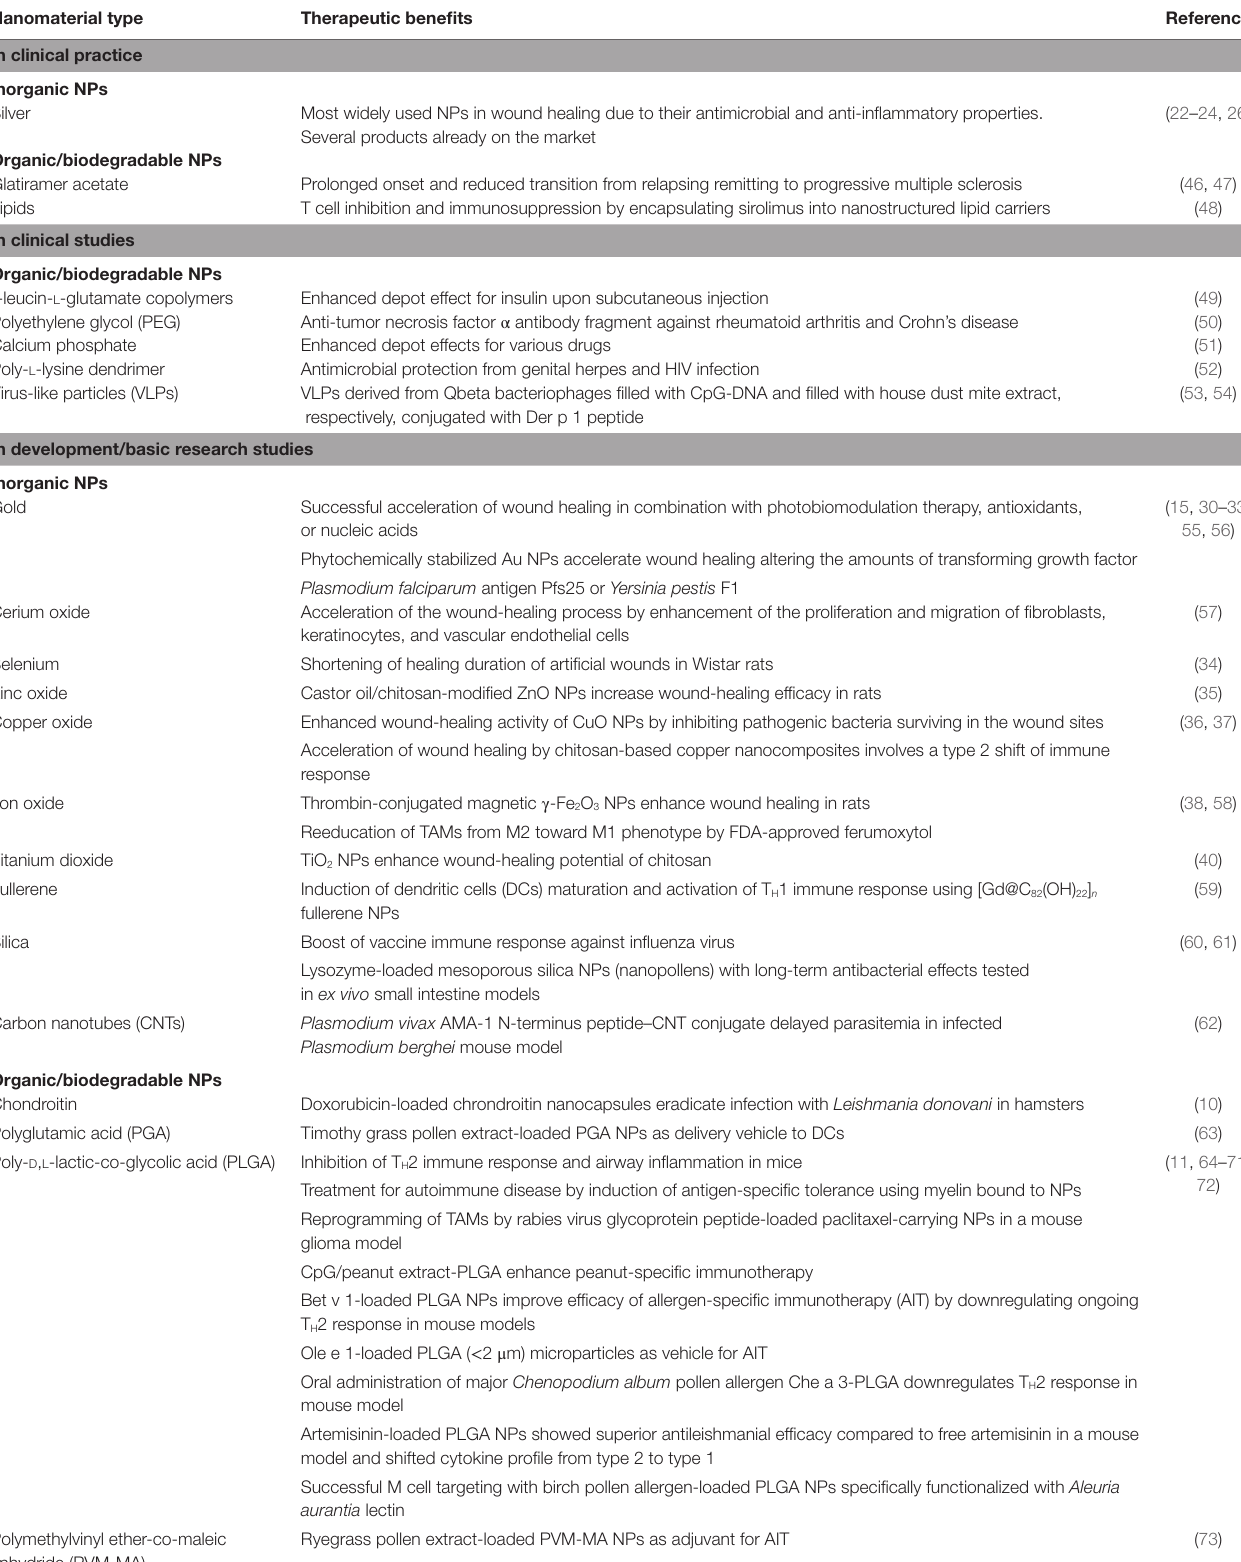
TAbLe 1 | Selected therapeutic nanoparticle (nP)-based approaches in the context of type 2 immune responses at different stages of